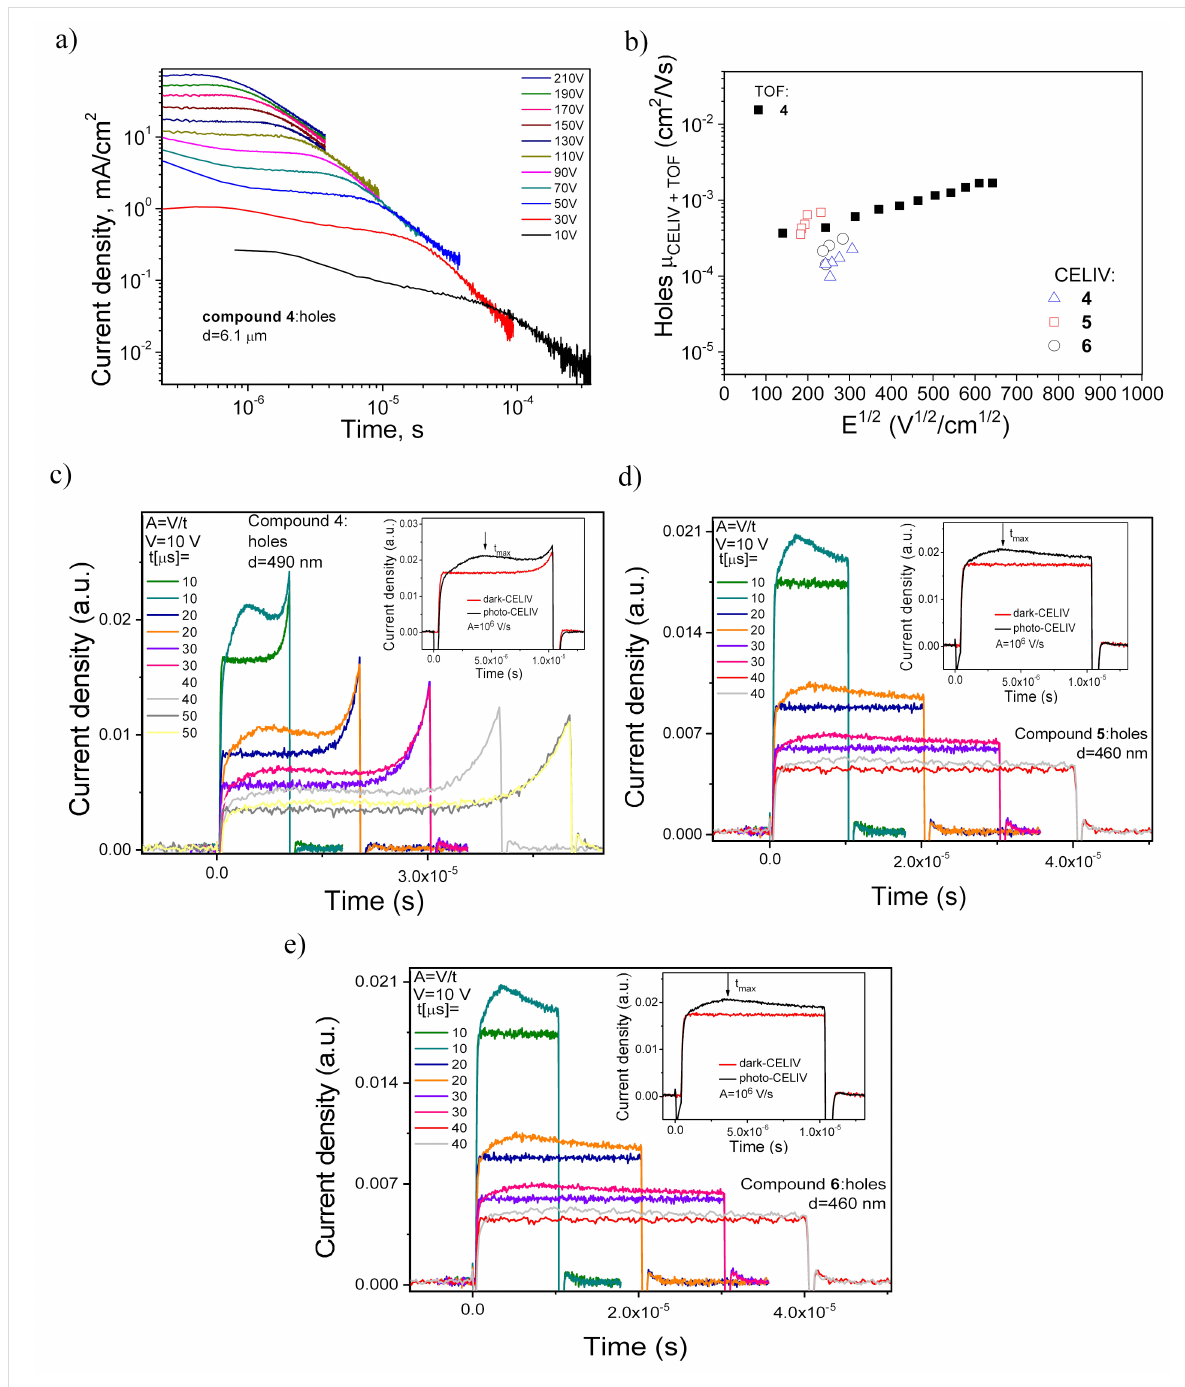
Figure 5: TOF photocurrent transients for holes in vacuum-deposited layers of compound 4 (a); hole mobility versus electric field for layers of com- pounds 4–6 (b); dark-CELIV and photo-CELIV signals for compounds 4 (c), 5 (d), and 6 (e).